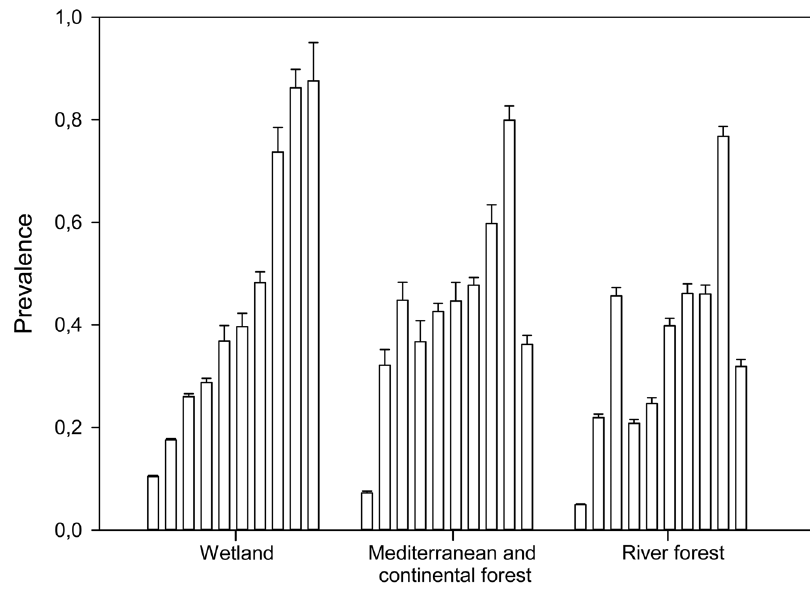
Figure 4. Feather mite prevalence (proportion of birds with feather mites) for ten species of well-sampled resident passerines in three habitats. Species are ordered from left to right within each habitat according to their prevalences in wetlands as follows: Phylloscopus collybita, Acrocephalus scirpaceus, Carduelis chloris, Cettia cetti, Cyanistes caeruleus, Luscinia megarhynchos, Erithacus rubecula, Serinus serinus, Sylvia atricapilla and Fringilla coelebs . ‘‘Breeding’’ and ‘‘habitat’’ variables were retained as fixed factors in the GLMM, while ‘‘observer’’ and ‘‘species’’ were included as random factors.